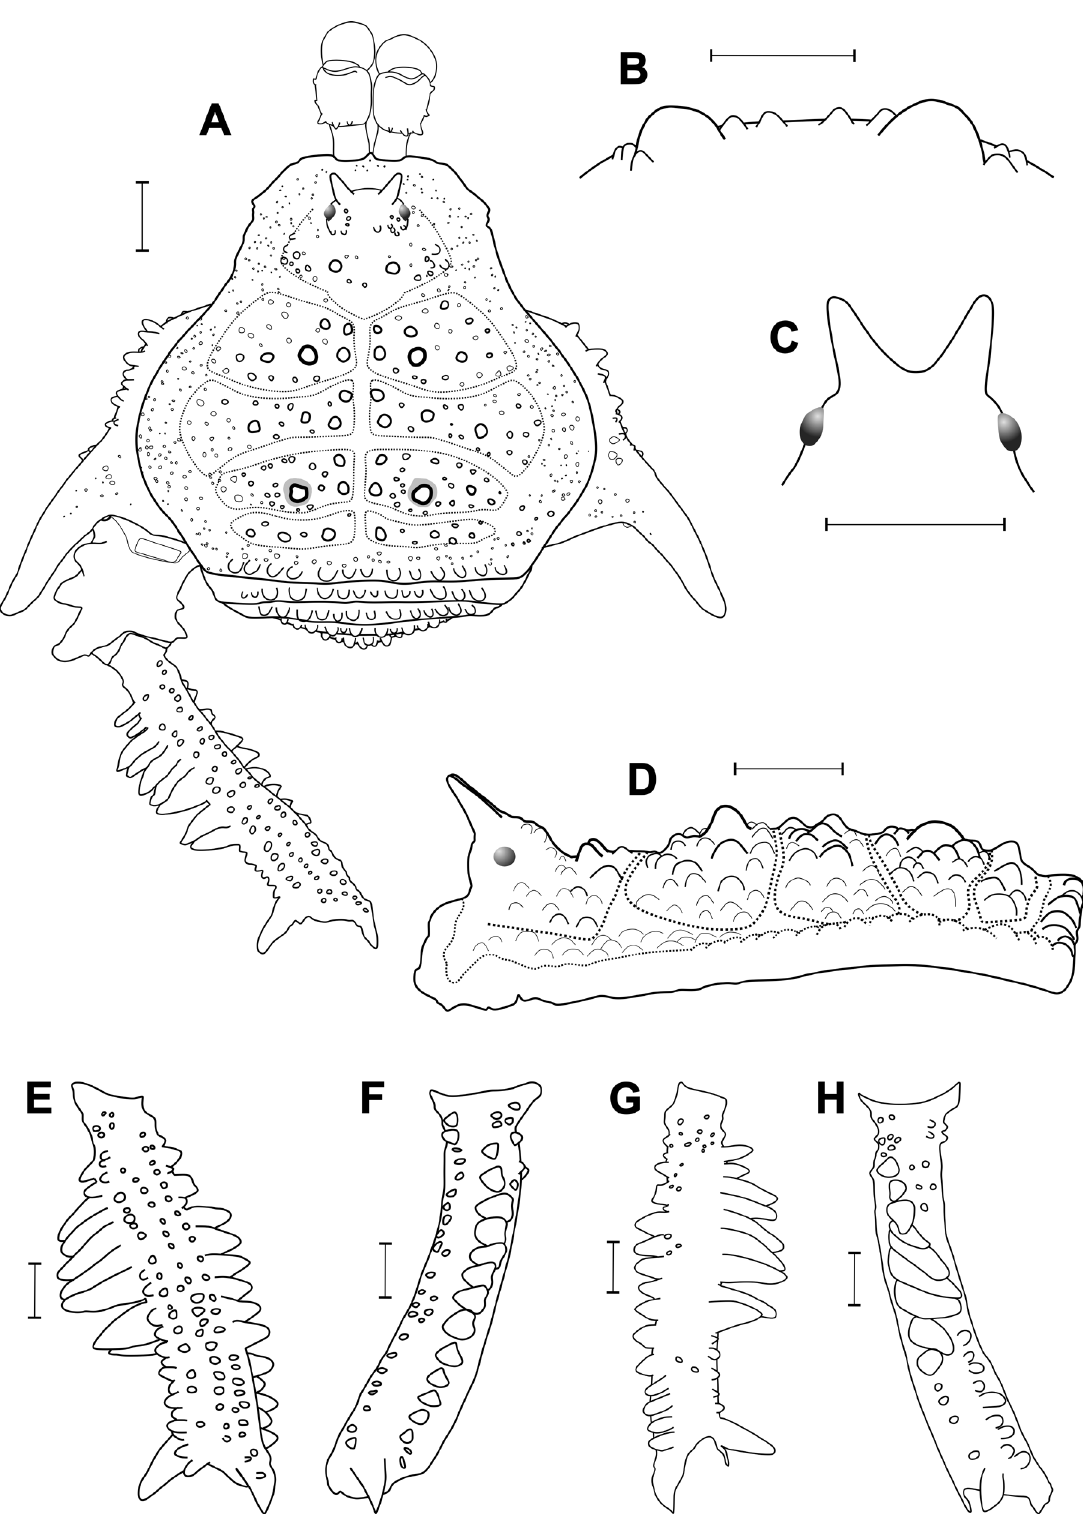
Fig. 7. Amazochroma pedroi gen. et sp. nov., ♂, holotype (MNRJ 2352). A . Habitus, dorsal view. B . Armature of scutal area III, posterior view. C . Ocularium, frontal view. D . Habitus, lateral view. E . Left femur IV, dorsal view. F . Same, retrolateral view. G . Same, ventral view. H . Same, prolateral view. Scale bars = 1